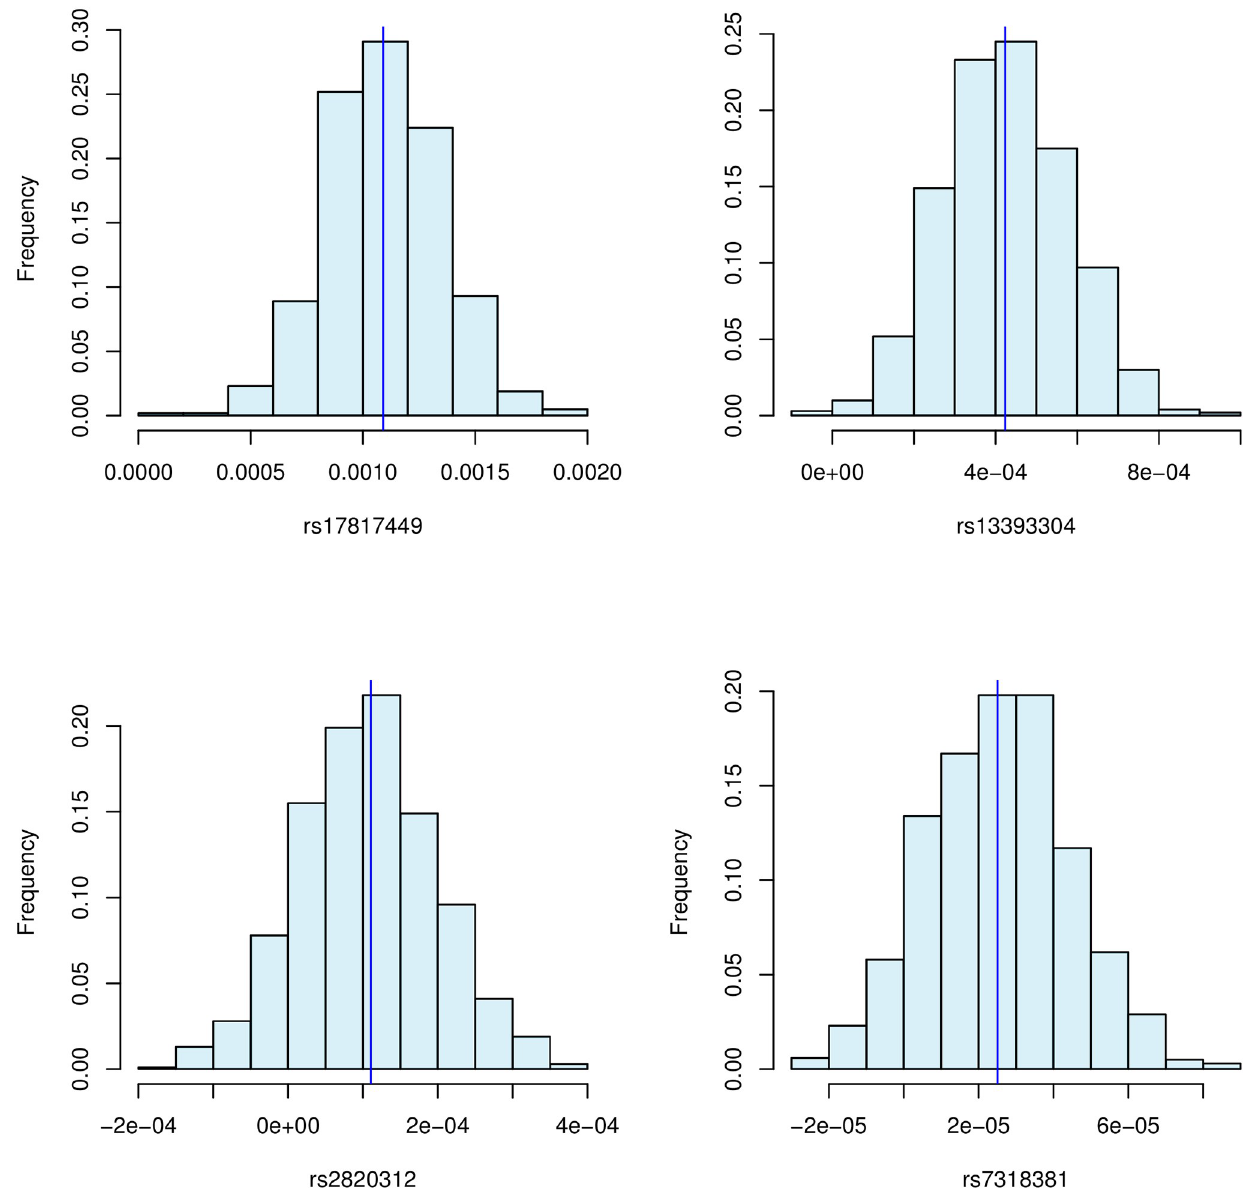
Fig 4. The estimates and corresponding uncertainties in the Sub-SAGE values for the four SNPs agree with previous studies (GWAS) regarding SNP- association with obesity.